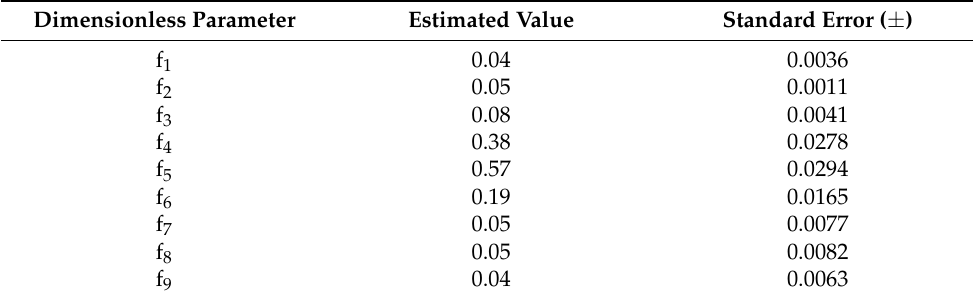
Table 8. Statistical parameters. Dimensionless Parameter Estimated